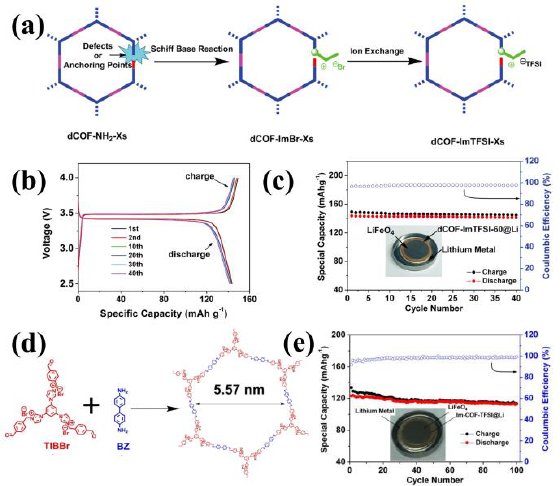
Figure 10. ( a ) Synthesis of dCOF − ImTFSI via ion exchange method; Charge − discharge curves ( b ) and cycling performance ( c ) of Li/dCOF − ImTFSI@Li/LiFePO 4 at 0.1 C under 80 °C. Reproduced with permission Ref. [63], Copyright (2020), John Wiley and Sons; ( d ) Synthesis of Im − COF; ( e ) cycling performance of the Li/Im − COF − TFSI@Li/LiFePO 4 at 0.1 C at 80 ◦ C. Reproduced with permission from Ref. [64], Copyright (2020), Royal Society of